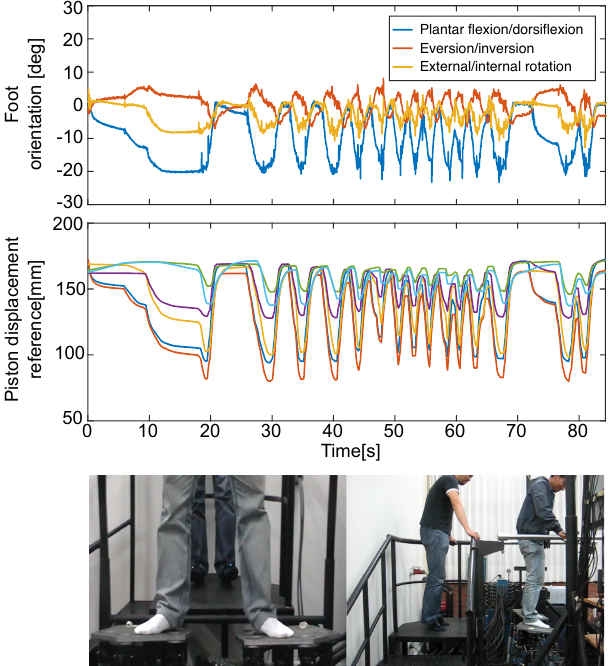
Figure 4. Experimental data from an TMM trial. Top panel shows data from the sensors, which are used to compute the piston displacement reference shown in the center panel. Bottom panel shows two figures that serve to illustrate two distinct instants from the trial. The therapist, using the wireless inertial sensors, input desired set of movements to the mechanical system that are replicated and transmitted to the patient (over the SGP). The tele-rehabilitation feature of the system allows the therapist to conduct this procedure from a remote